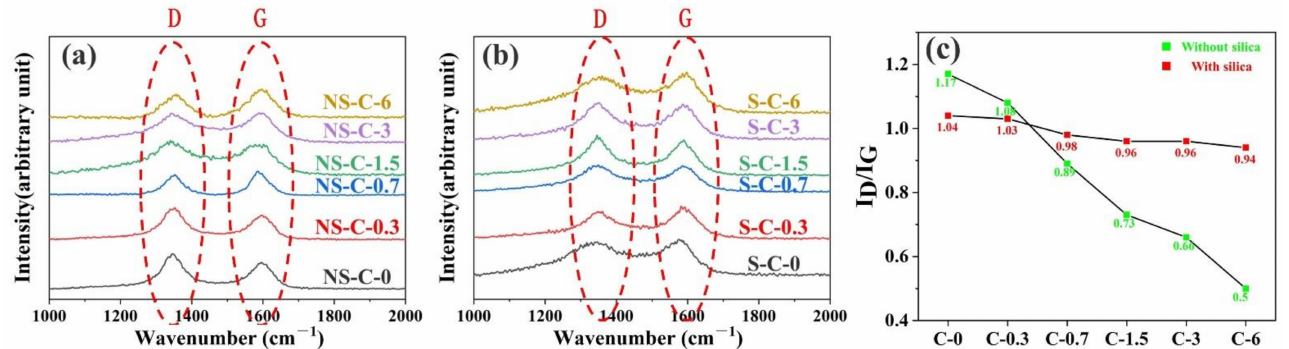
Figure 6. Effects of MWCNTs content on the Raman spectrum of char layers: group NS ( a ), group S ( b ), and I D /I G ( c